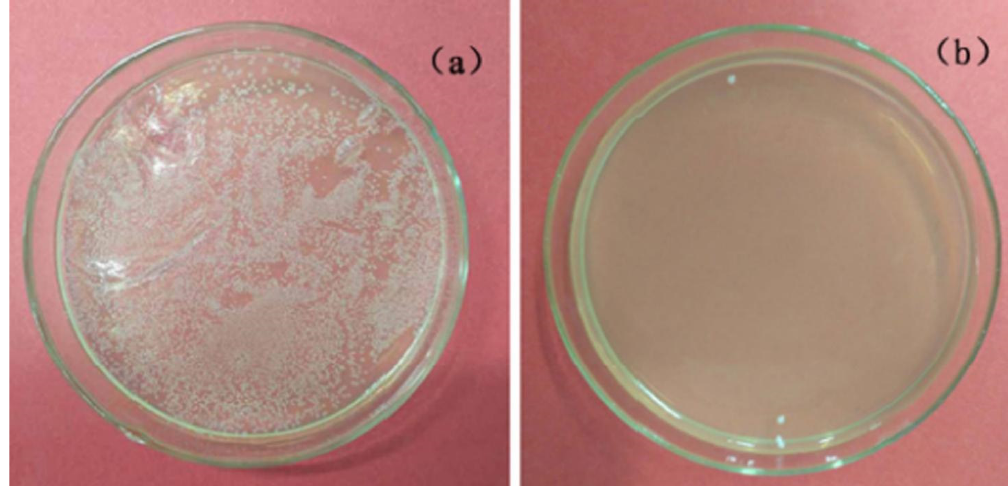
Figure 5. E. coli bacterial colonies on di ff erent samples after a 12 h incubation. ( a ) NPSS, ( b ) Cu/NPSS.